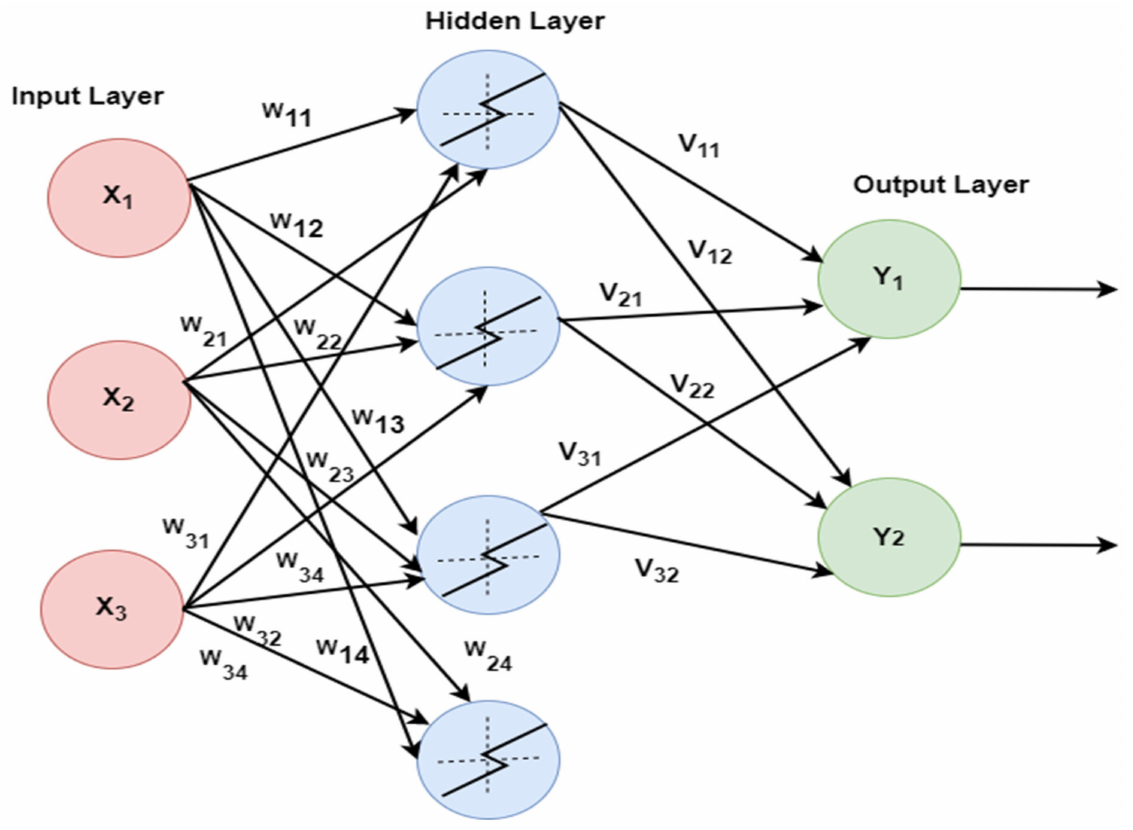
Figure 1. Feed-forward neural network